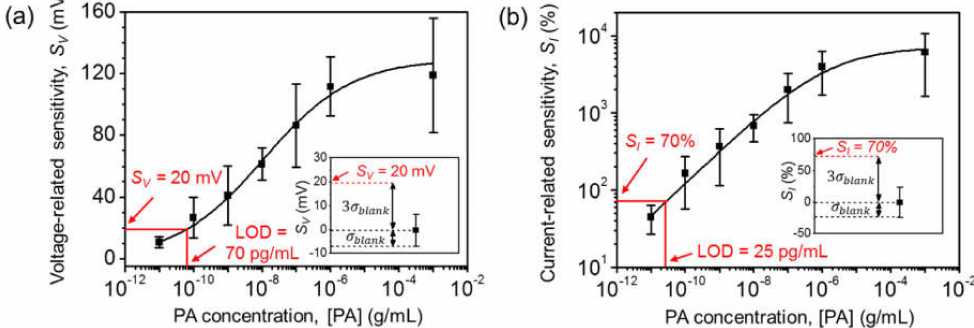
Figure 6. [PA] vs. ( a ) S V and ( b ) S I at I D,Ab = 100 pA. The solid lines which are showed in the figures are logistic fitted lines. Inset: S V , S I of blank replicates (1 × PBS solution with no PAs), and S V , S I at the LOD using the three-sigma method.